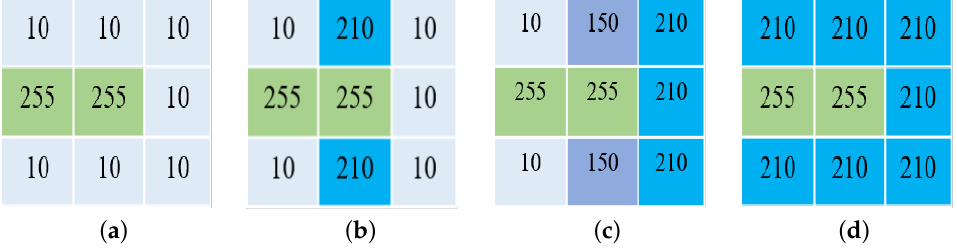
Figure 11. The relationship between the target and the background; 255 in green, 210 in blue, 150 in gray, and 10 in light color represent the target, bright background, transition region and dark background, respectively. ( a – d ), respectively, represent the target in the dark background area, a small amount of noise area, transition area, and the bright background